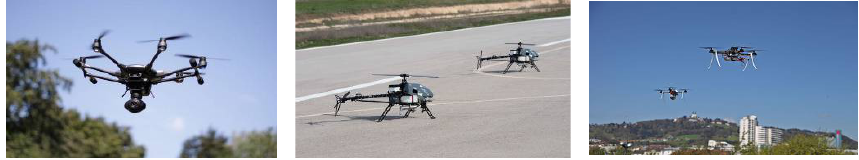
Figure 4. Some samples of challenges related to lack of scalability.